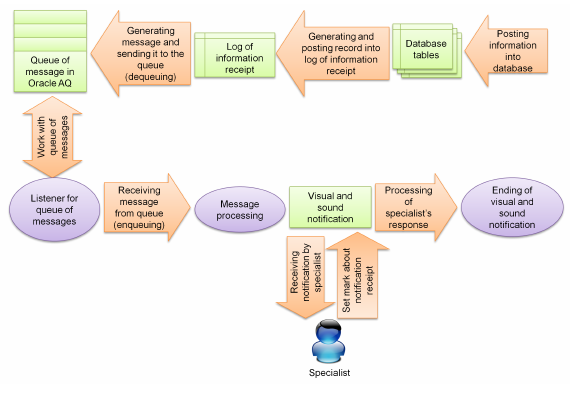
Figure 1. The propagation of messages about receiv- ing new data